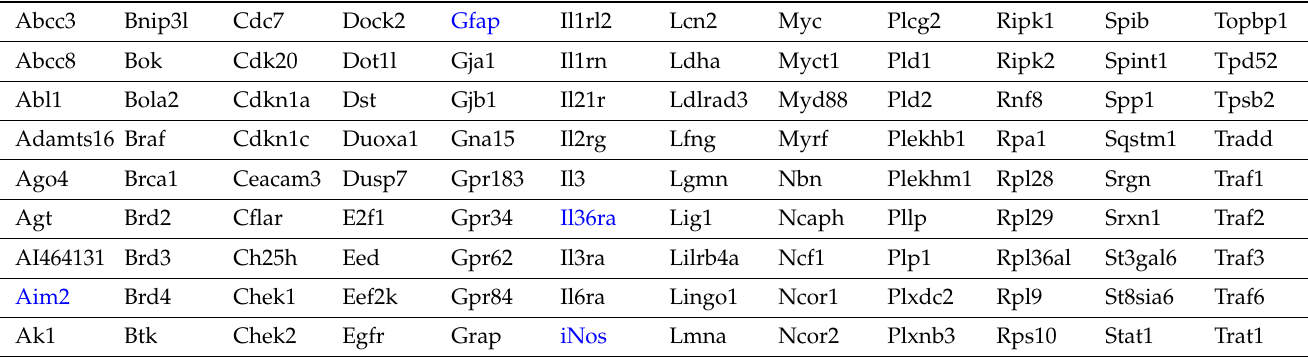
Table 1. A comprehensive list of genes investigated in this